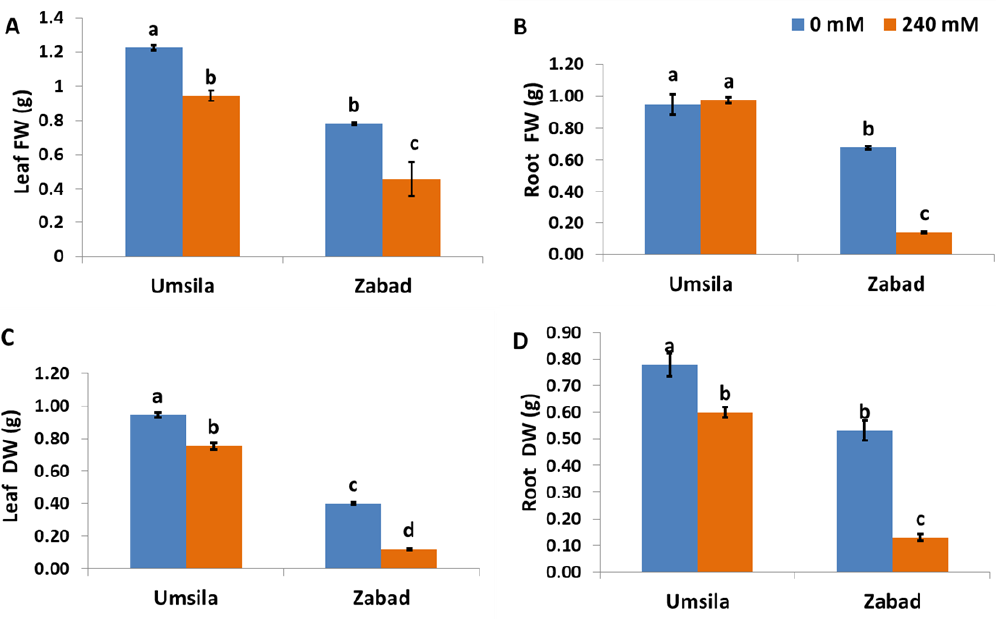
Figure 1. The effect of salinity on the fresh weight ( A , B ) and dry weight ( C , D ) of date palm seedlings when subjected to control (0 mM NaCl) and salinity (240 mM NaCl) conditions. Bars represent the mean ± SE ( n = 3).